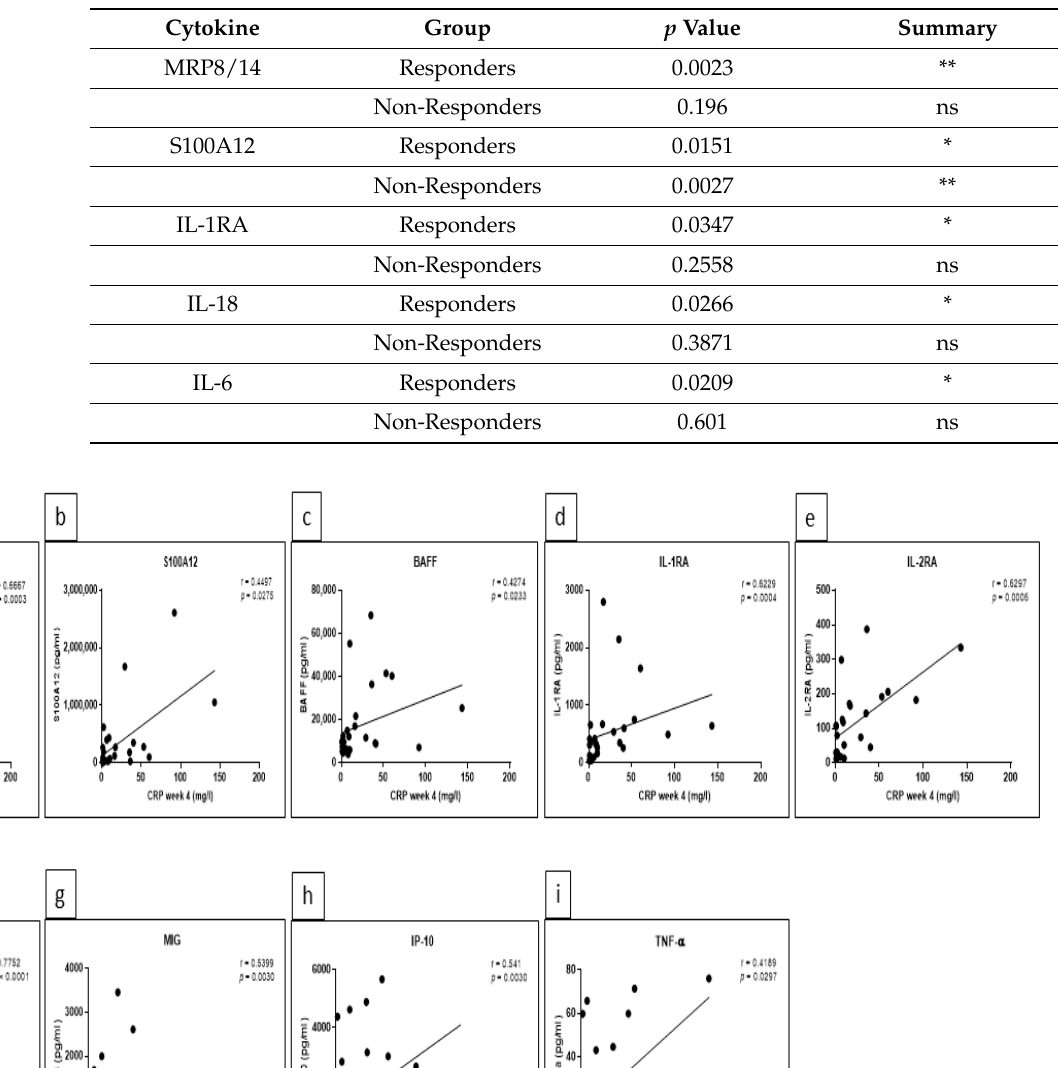
Table 5. Detailed results of t -test between week 0 and week 4 for responder and non-responder groups separately. * p < 0.05, ** p < 0.01.